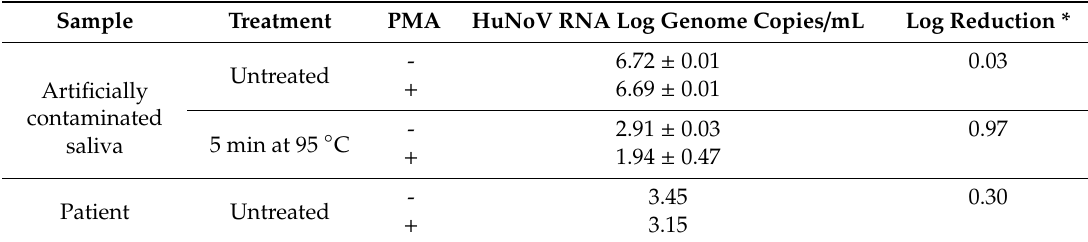
Table 5. Viability propidium monoazide (PMA)xx RTqPCR assay of HuNoV GII present in artificially contaminated saliva and in the saliva of one